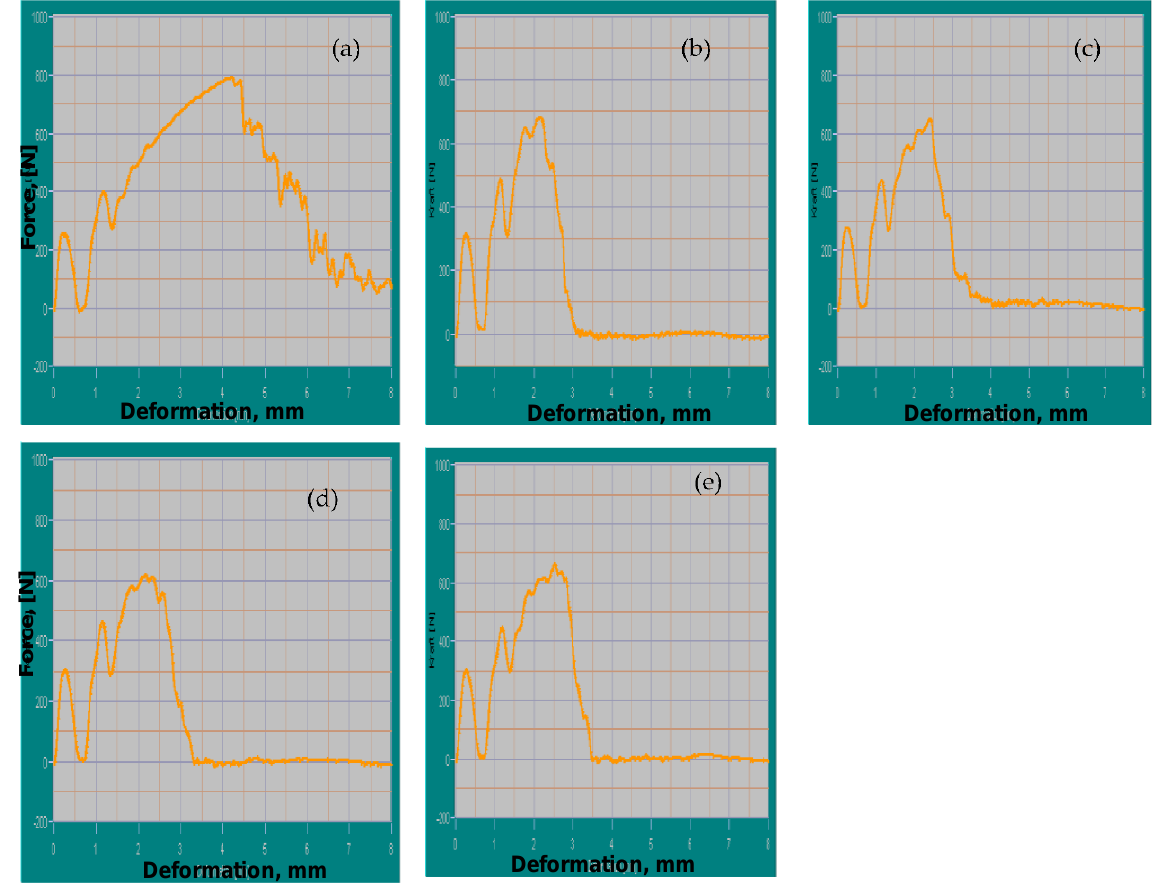
Figure 5. Impact bending strength of untreated and PF resin-treated wood samples. ( a ) Untreated control, and wood treated with PF resins with M w values of ( b ) 237, ( c ) 305, ( d ) 403, and ( e ) 520 g/mol.